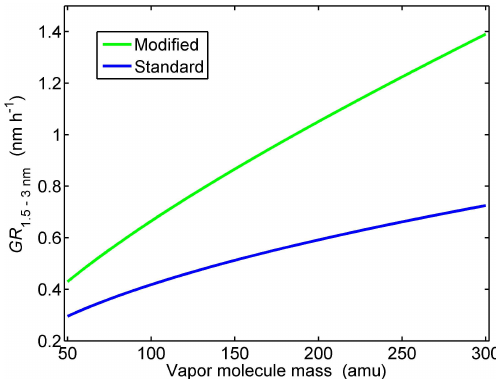
Fig. 2. Vapor concentration required for growth rate of 1nm/h as function of particle diameter. Vapor is assumed to have molecu- lar properties of sulphuric acid (molecule mass 98amu and liquid phase density 1.83gcm − 3 ) and negligible saturation vapor pres- sure. Particle density is assumed to be equal to the vapor liquid phase density. “Modified” refers to the method of this study and “standard” to the Fuchs-Sutugin approach. Dashed lines show the kinetic (or free-molecular) and continuum regime results.